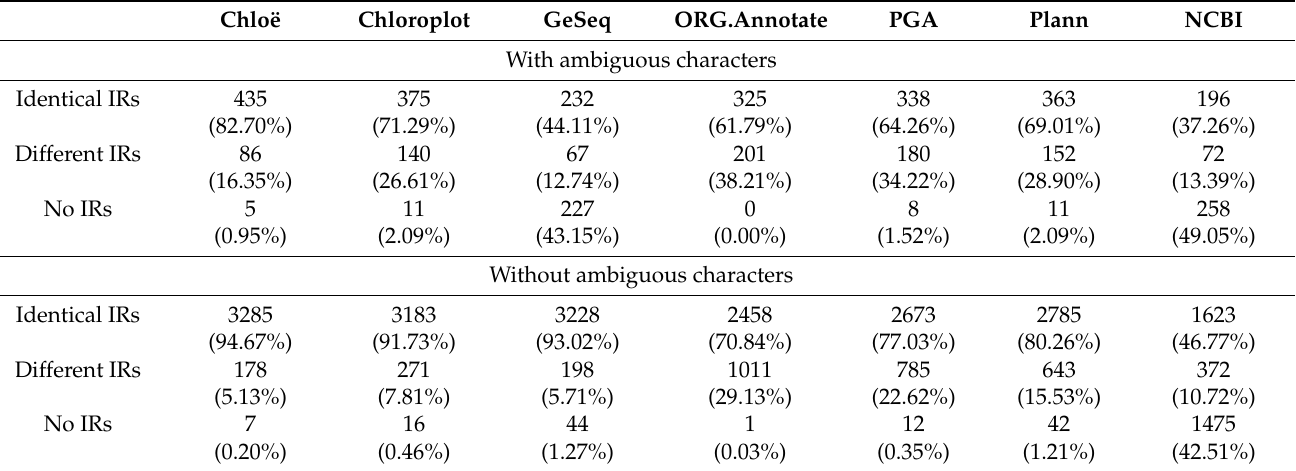
Table 5. Number of sequences in which the IR regions were identified (identical or different) using six annotation tools (and those annotated in NCBI) in the datasets of sequences with and without ambiguous